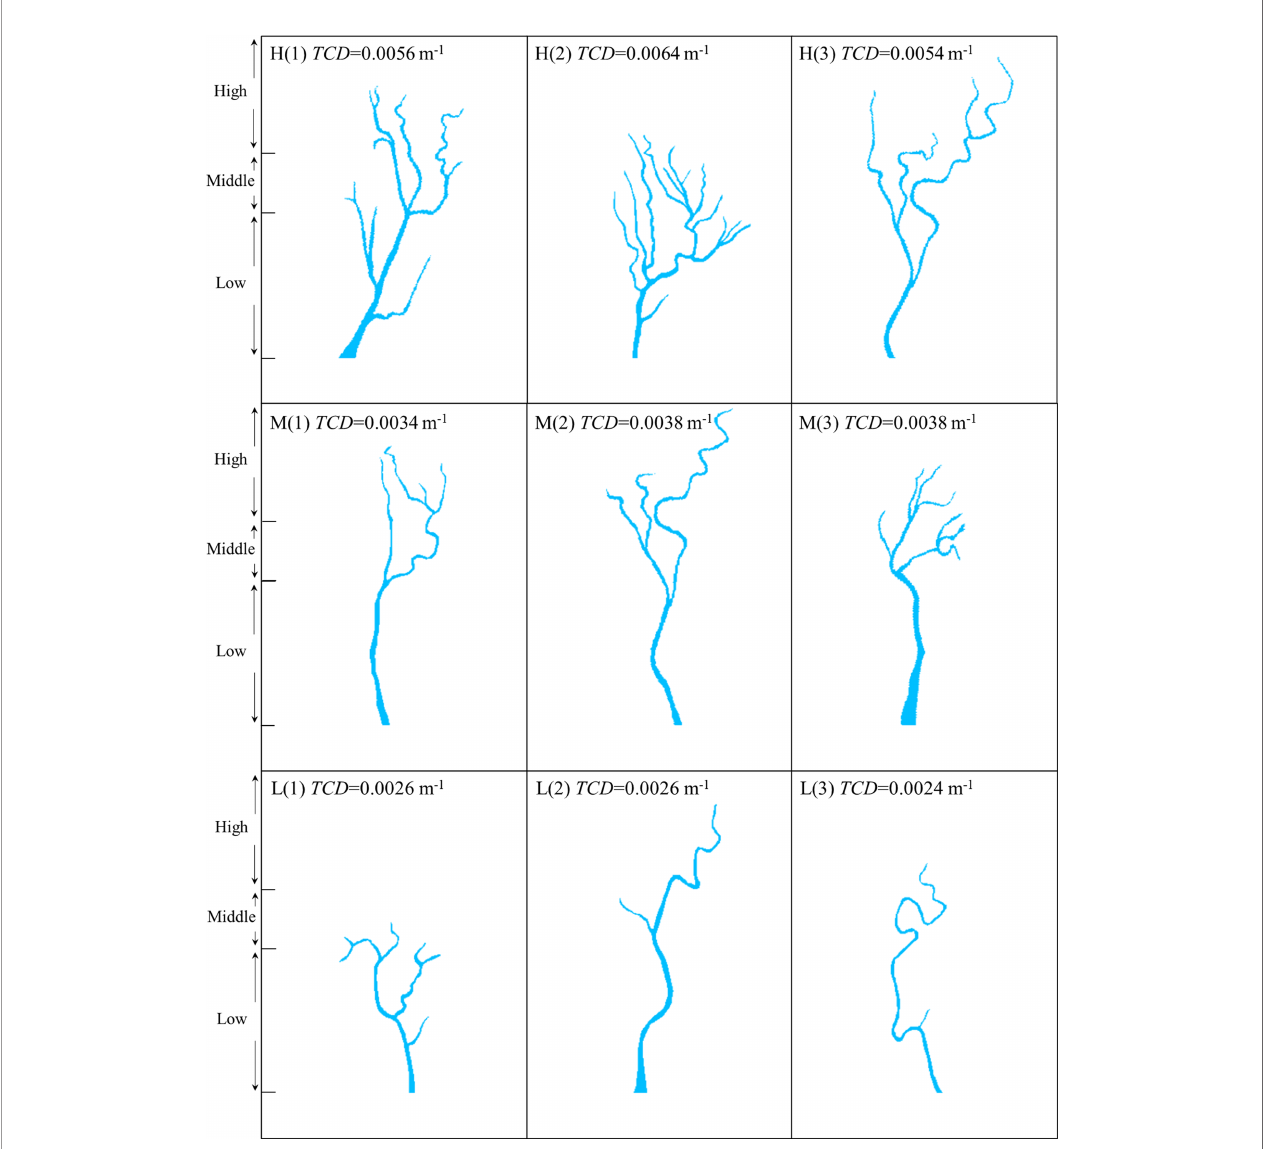
FIGURE 2 | The geometries of tidal channel networks used in our numerical experiments. (H) High tidal channel density; (M) Middle tidal channel density; (L) Low tidal channel density. The marsh platform was divided into low, middle and high marshes based on